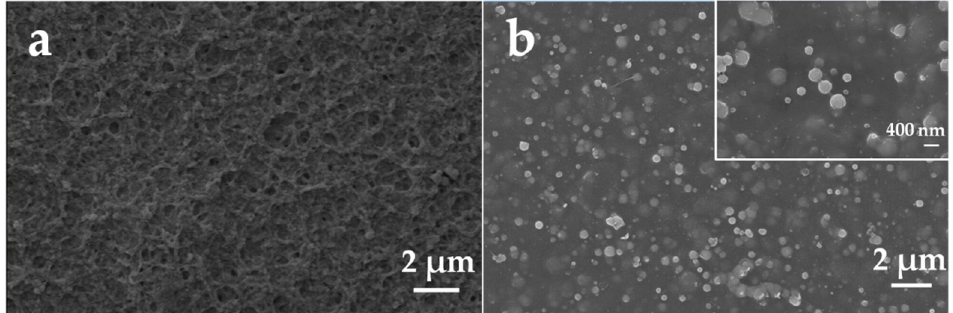
Figure 1. SEM images of ( a ) ZnAlg and ( b ) ZnAlg / Cu 2 O composites. The inset in ( b ) is its magnified image.